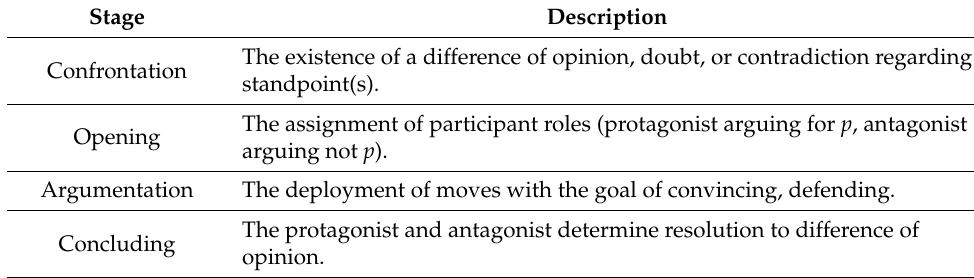
Table 2. Stages of argumentation in